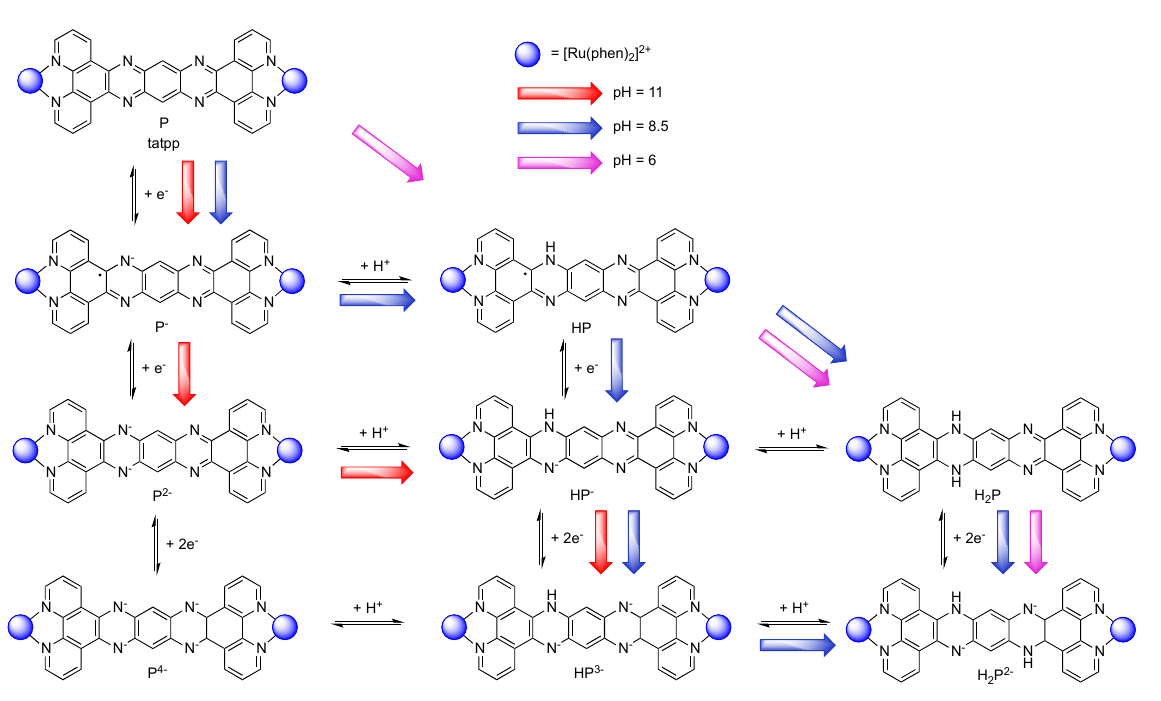
Figure 55. Electron and proton transfer processes in water at pH 11 (red), 8.5 (blue) and 6 (pink) [216].